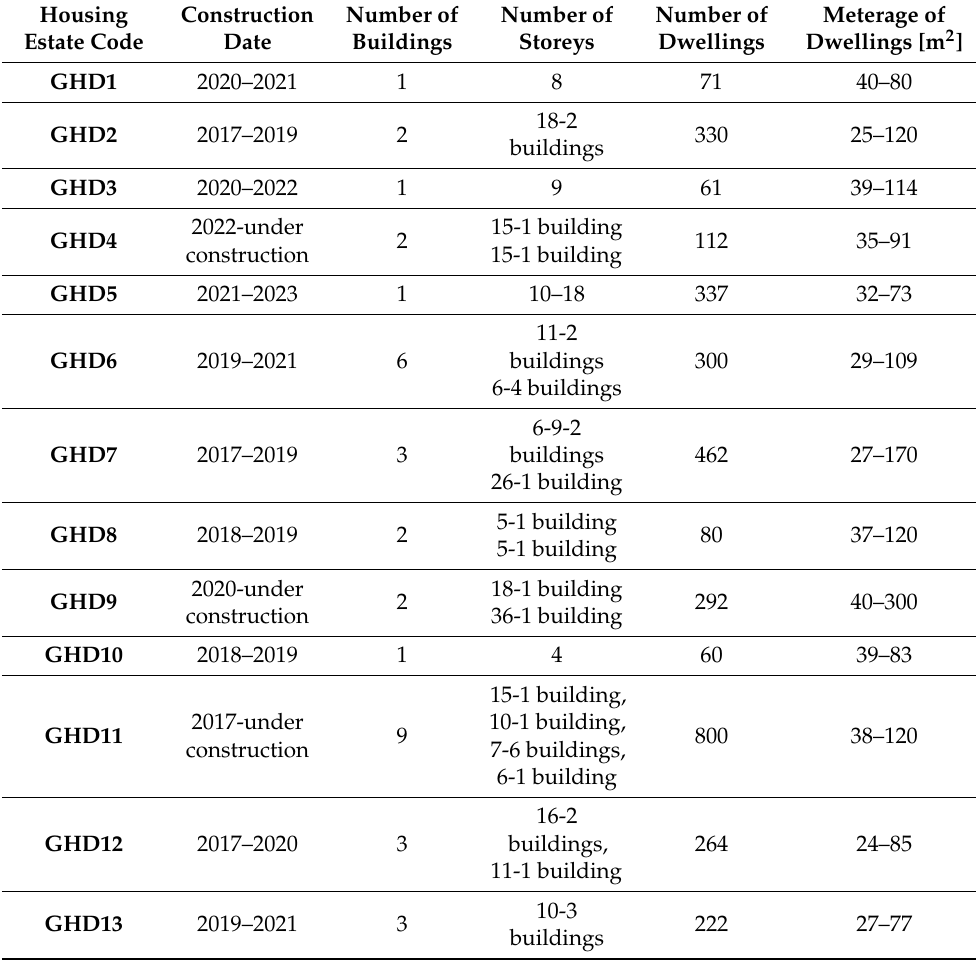
Table 2. Data on 13 GHDs that construction started from 2019 to 2023 in Rzeszow.